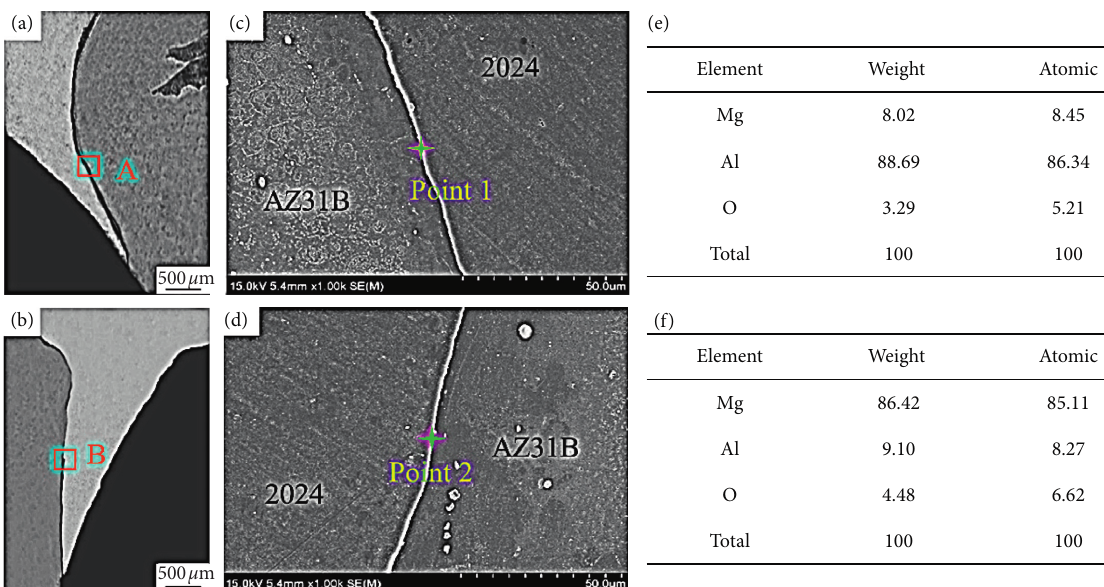
Figure 10: The macroscopic appearance of the kissing bond defect of (a) RS and (b) AS of sample WS30. The enlarged SEM views of A region (c) and B region (d). The EDS result of point 1 (e) and point 2 (f) of the kiss bonding defects.